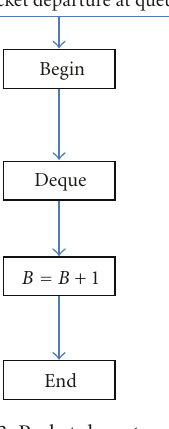
Figure 3: Packet departure event.